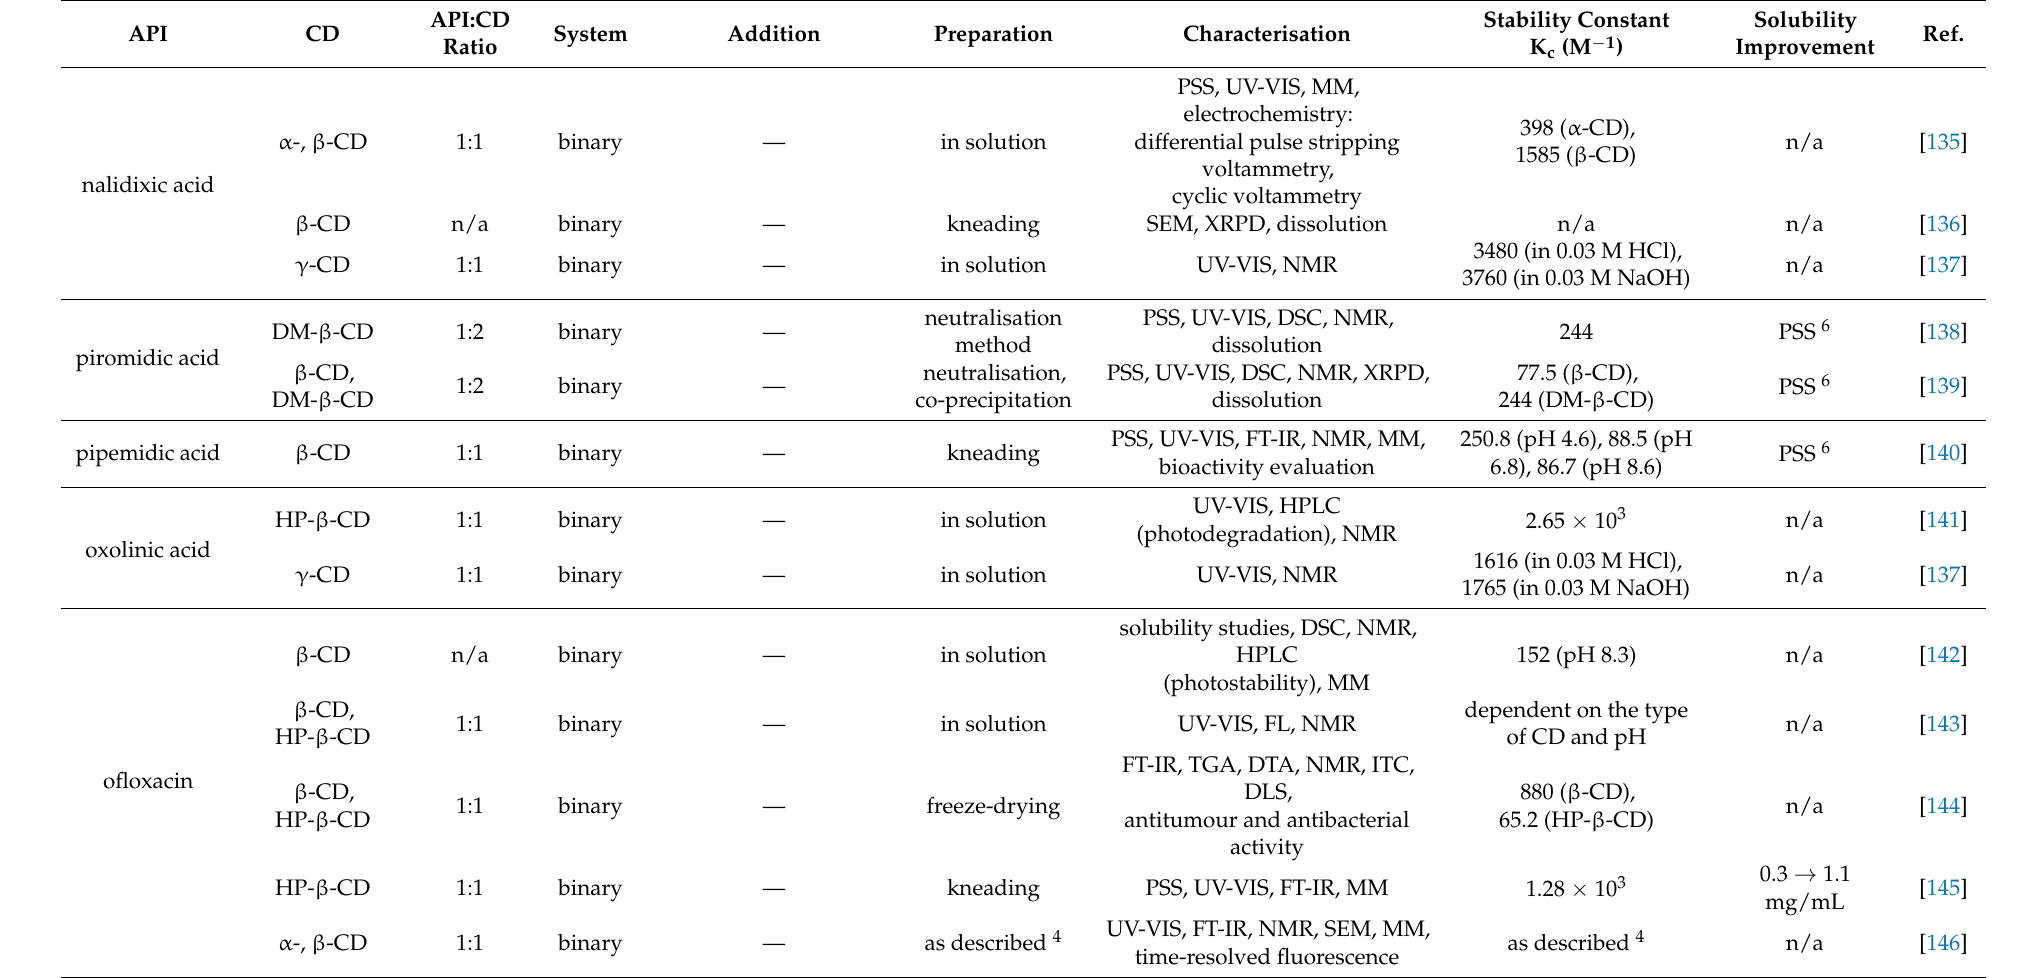
Table 6. Detailed information of quinolone complexes on the types of CDs used, methods of complex preparation, and techniques used to characterise the obtained products